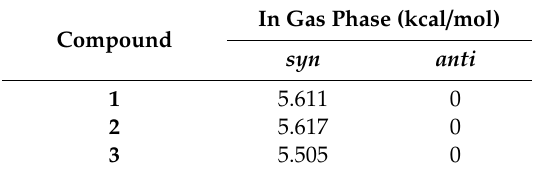
Table 3. Relative energies (kcal/mol) for the syn and anti conformations for 1-3. Compound